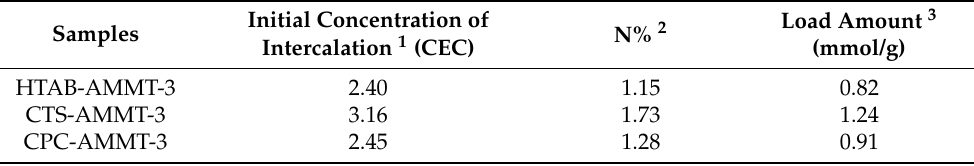
Table 3. Elemental analysis data of organo-modified